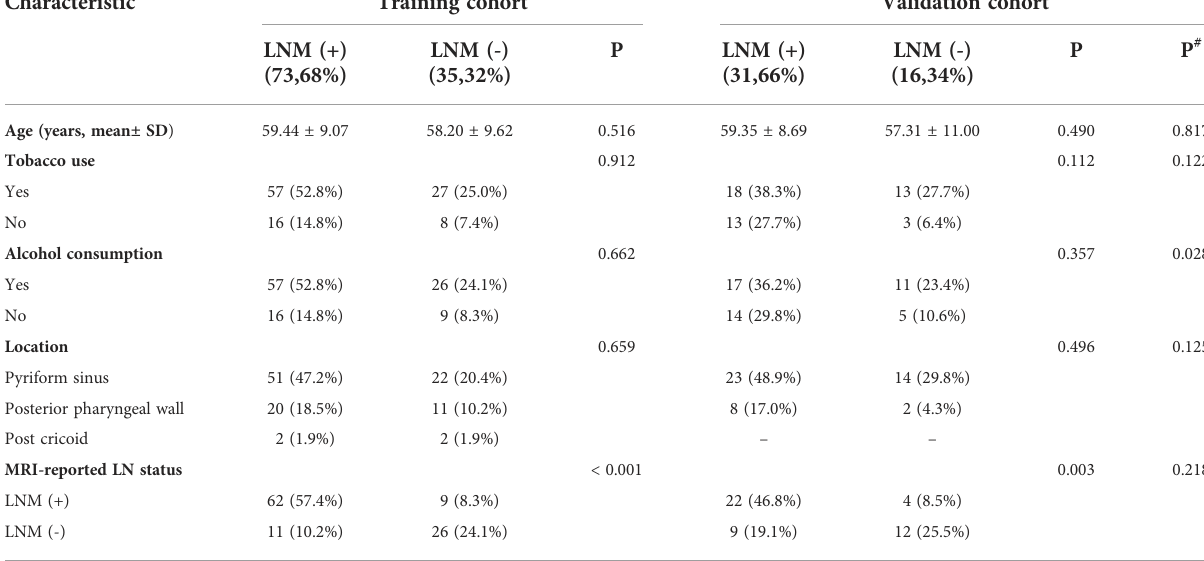
TABLE 1 Characteristics of patients in training and validation